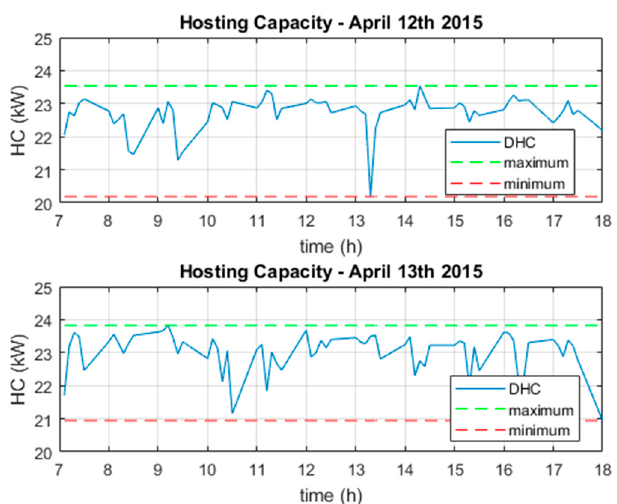
Figure 11. The daily DHC(t) for the in relation to April 10th and 11th, 2015.